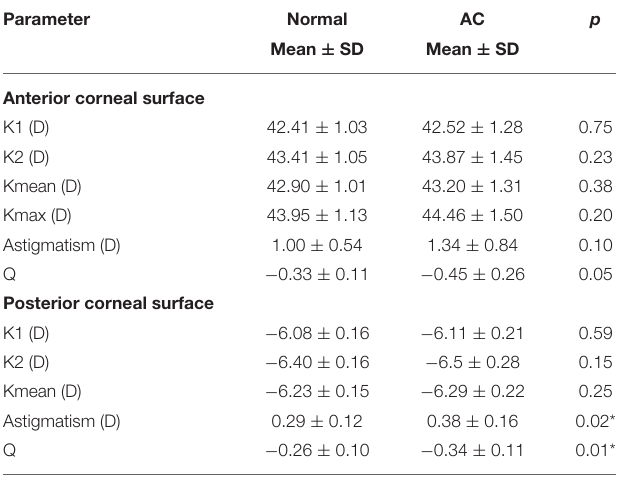
TABLE 2 | Comparison of corneal topographic parameters between the normal and AC groups.